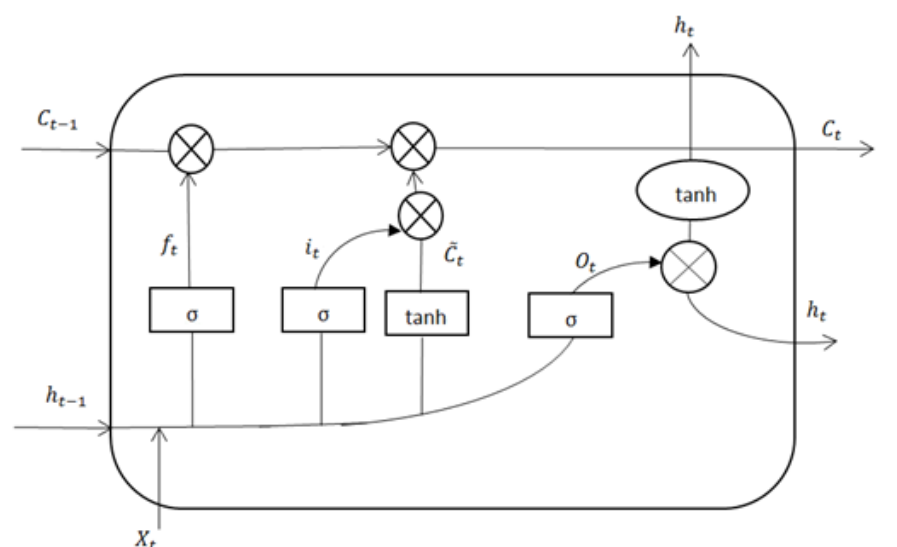
Figure 2. Network structure of LSTM.